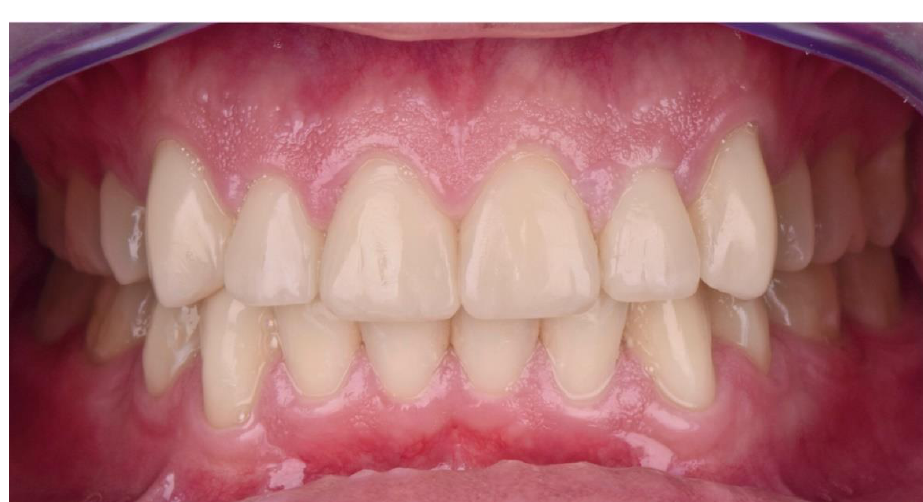
Figure 30. Final extraoral smile picture (front).